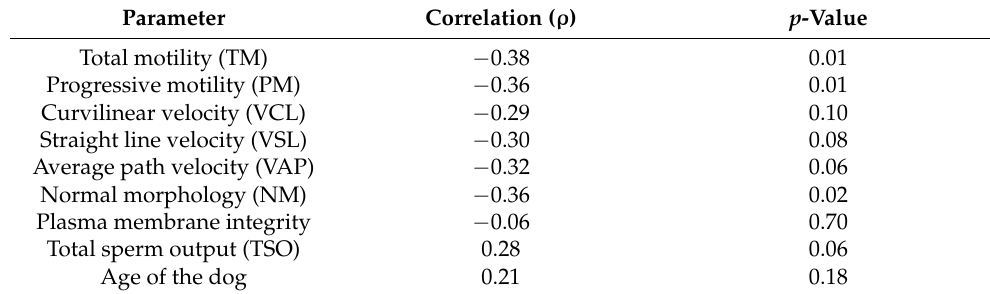
Table 1. Spearman correlation coefficients ( ρ ) between serum AMH concentration and different semen